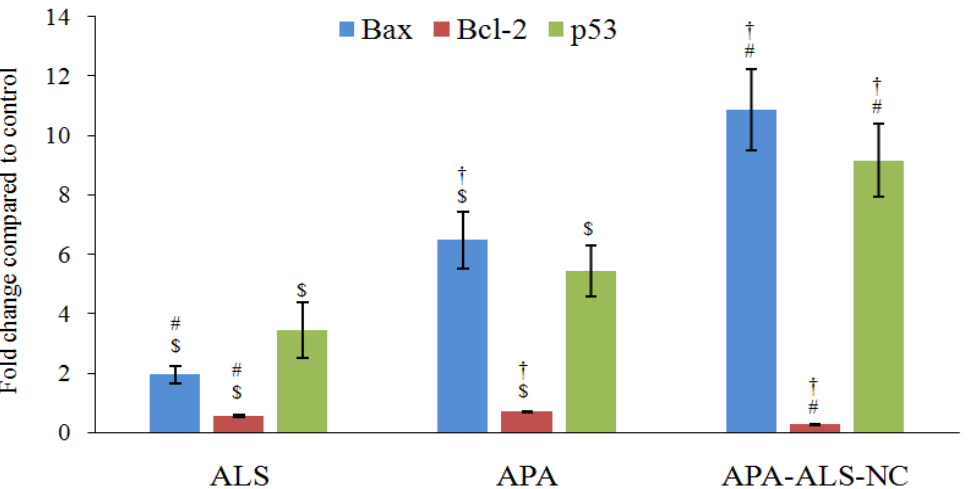
Figure 7. Effect of ALS, APA, and APA-ALS-NC samples on mRNA expression of Bax, Bcl-2, and p53. (Statistical inferences: † p < 0.05, in comparison to ALS; # p < 0.05, in comparison to APA; $ p < 0.05, in comparison to APA-ALS-NC).